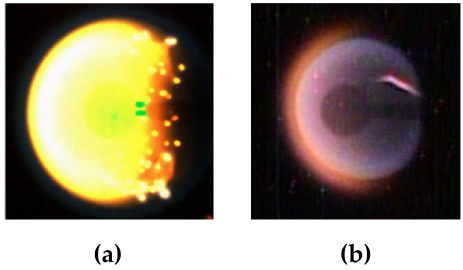
Figure 2. Photographs of the spherical diffusion flames of ethylene in the Flame Design (Adamant) SE under microgravity conditions on the ISS: ( a ) sooty normal flame; ( b ) sooty inverse flame [42,43].